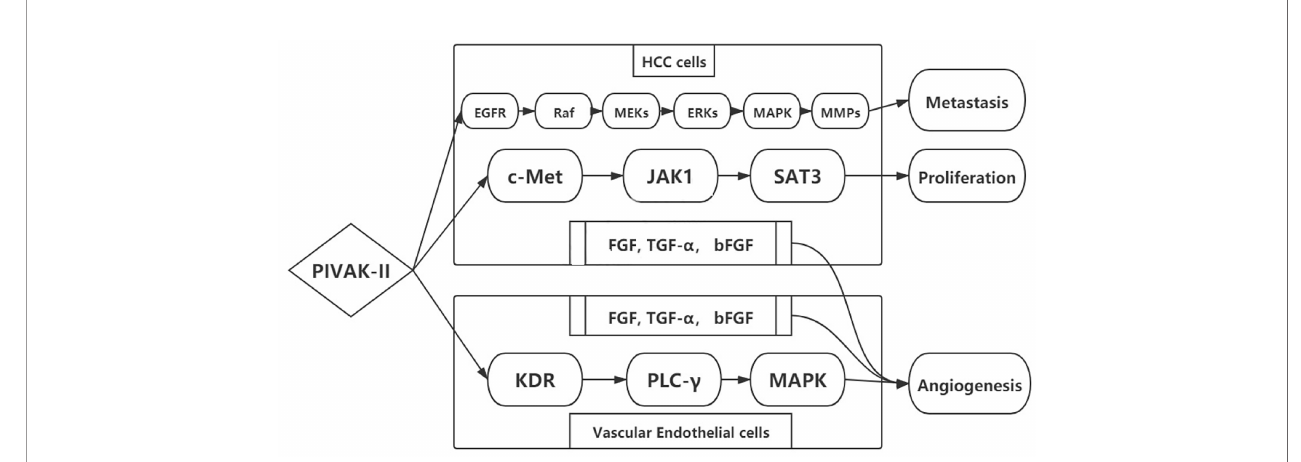
FIGURE 2 | Mechanism of PIVKA-II in HCC